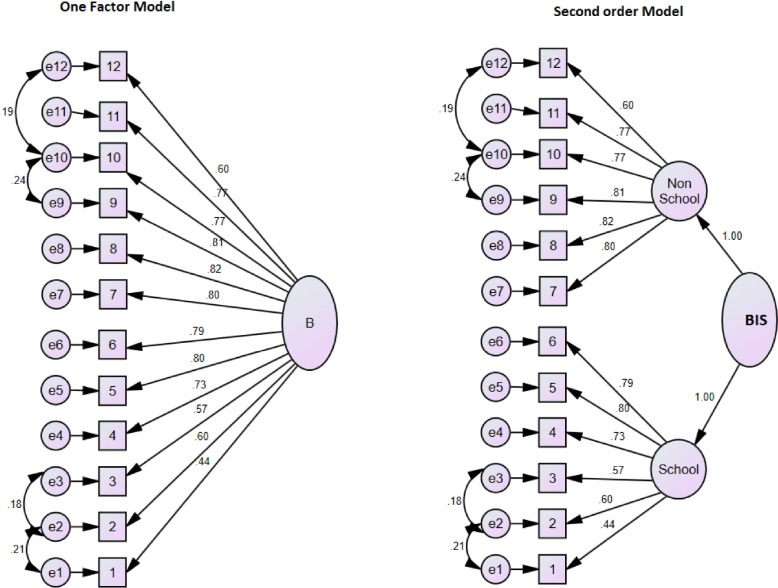
The CFA of the one-factor model and second-order CFA.